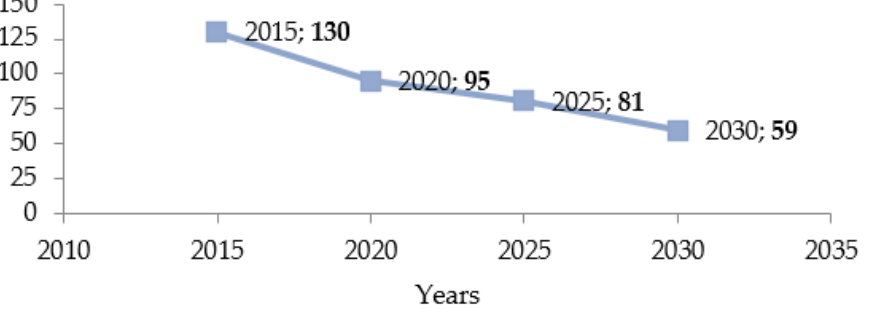
Figure 1. Graph of the target average CO 2 emissions [g/km]. Source: Own elaboration on the basis of dieselnet.com [44].